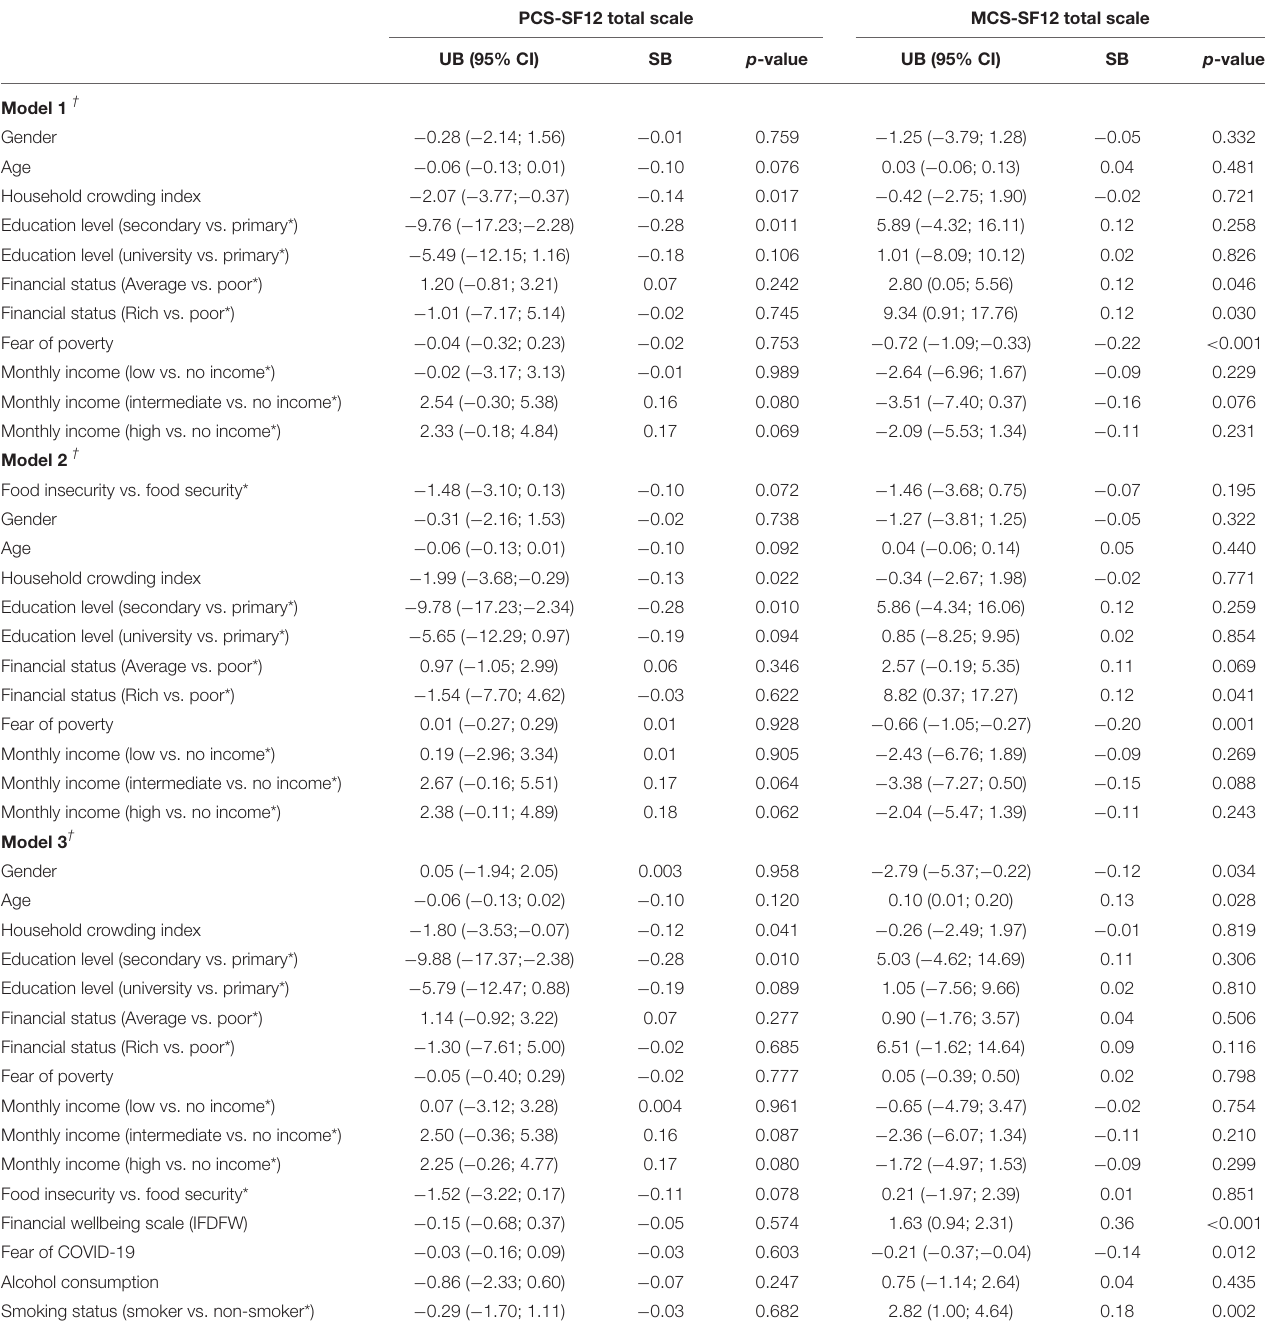
TABLE 4 | Multivariable analysis exploring associations between food insecurity, financial wellbeing sociodemographic and economic characteristics of study participants with their quality of life parameters [SF-12 components (PCS-SF12 and